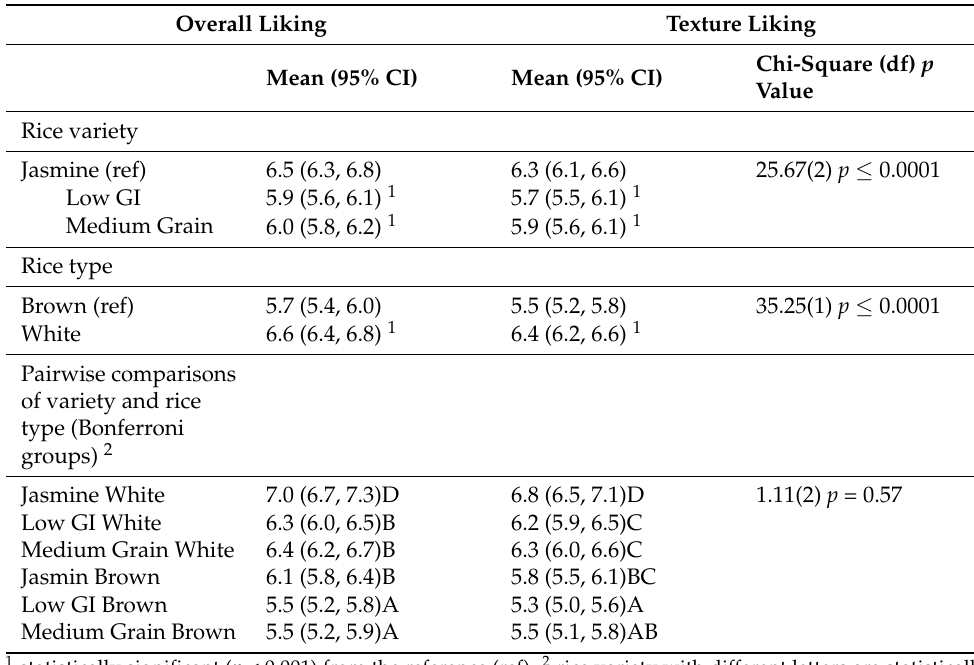
Table 4. Mix model (repeated measures) ANOVA table for brown and white rice varieties after